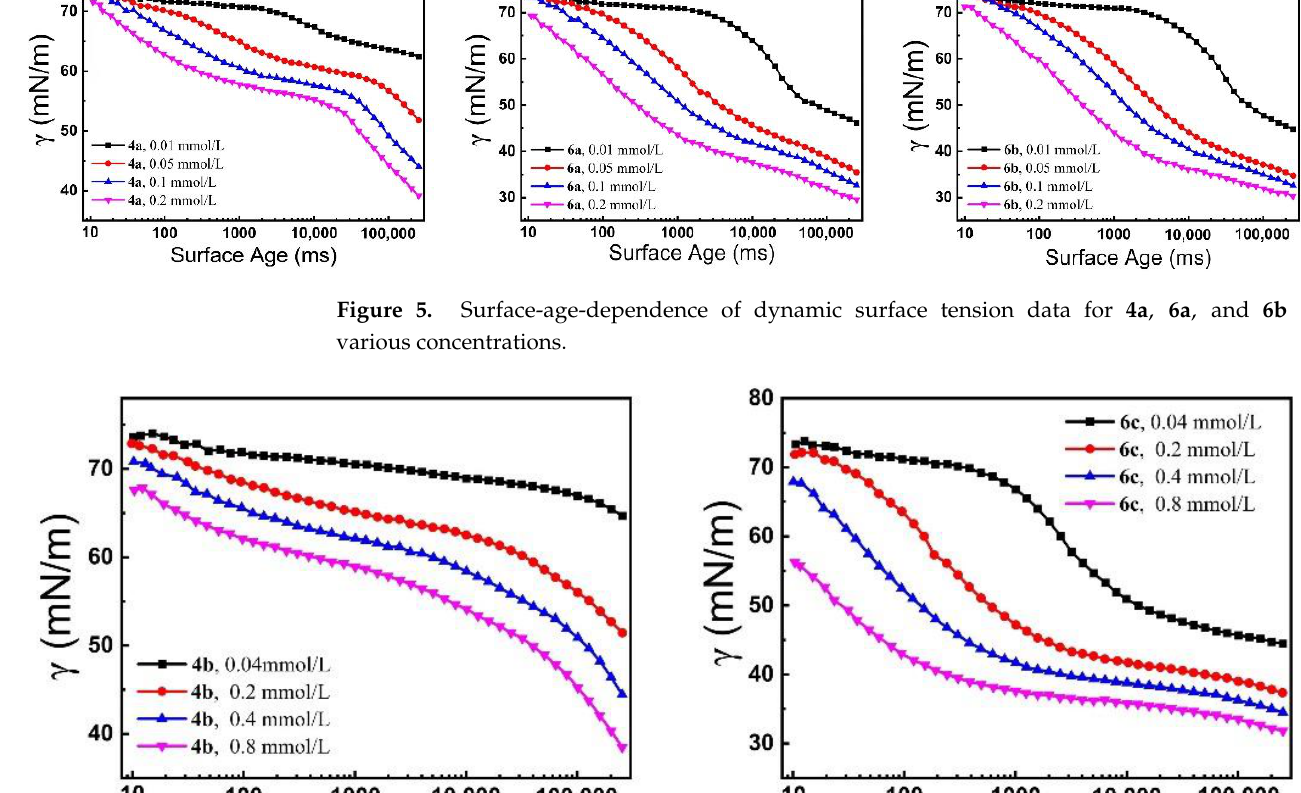
Figure 6. Surface-age-dependence of dynamic surface tension data for 4b and 6c at various concen- trations.